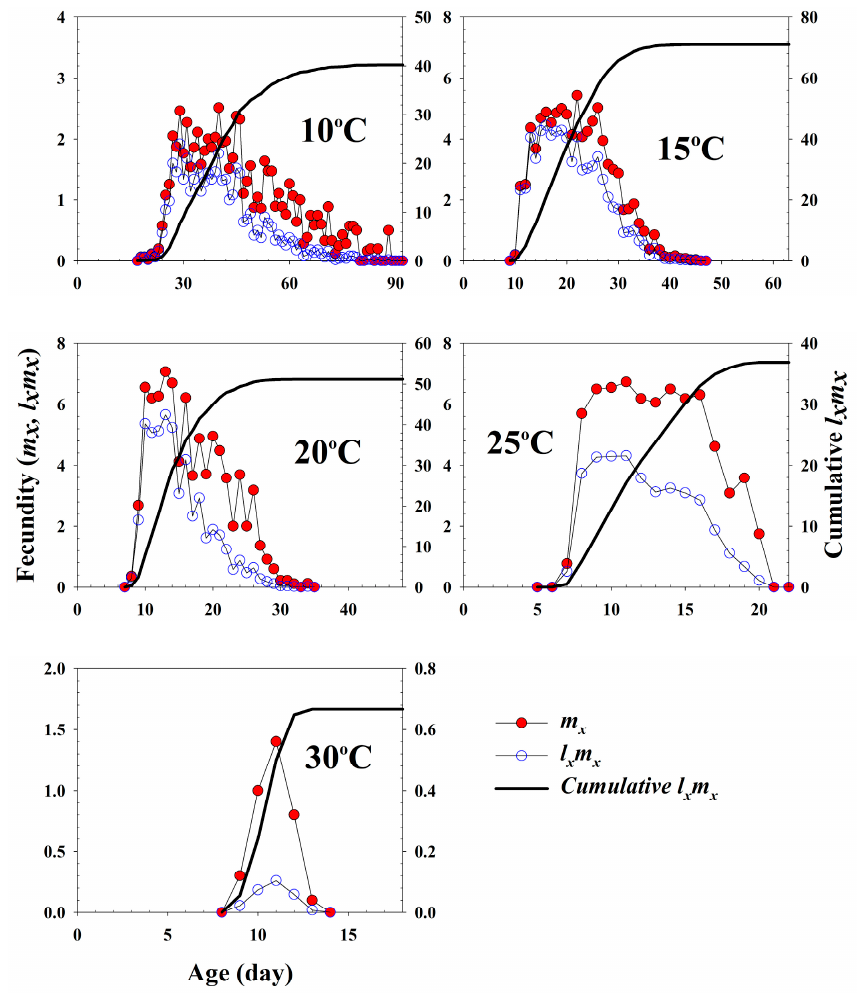
Figure 3. The age-specific fecundity ( m x ), the age-specific maternity ( l x m x ) and the cumulative reproductive rate ( (cid:1844) (cid:3051) = ∑(cid:1864) (cid:3051) (cid:1865) (cid:3051) ) of Acyrthosiphon pisum in response to different temperature conditions.